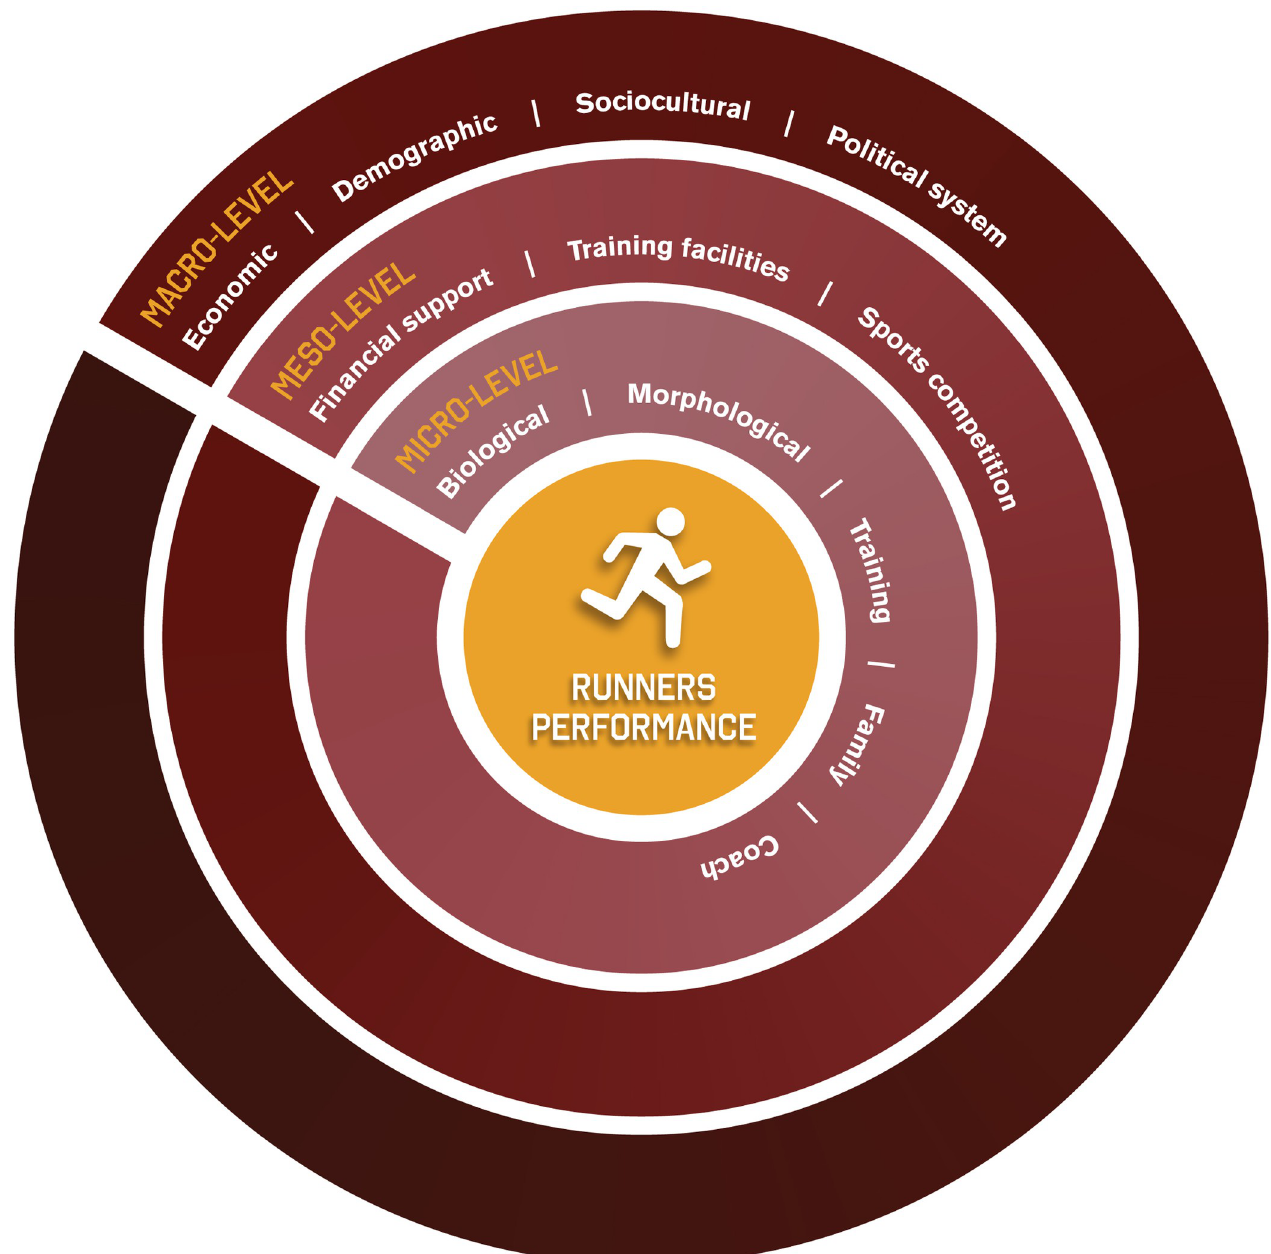
Fig 1. The theoretical approach of the InTrack